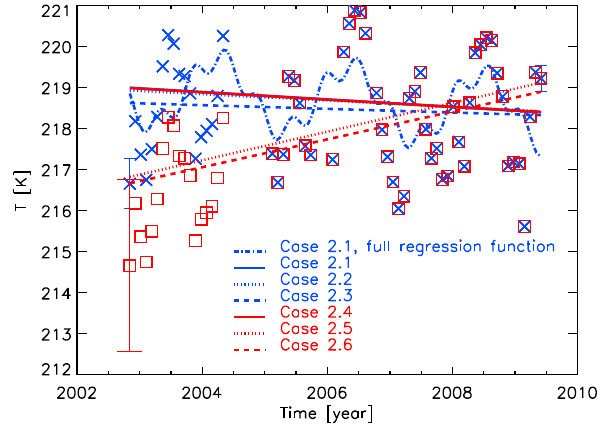
Fig. 3. Linear trends from MIPAS 32-day mean temperatures at 25km altitude, 30 ◦ S–30 ◦ N, using the discrete empirical periodical correction, as described in Sect. 3.2. Both the linear part of the regression function and the complete regression function are shown. No artificial bias has been added to the data in this case